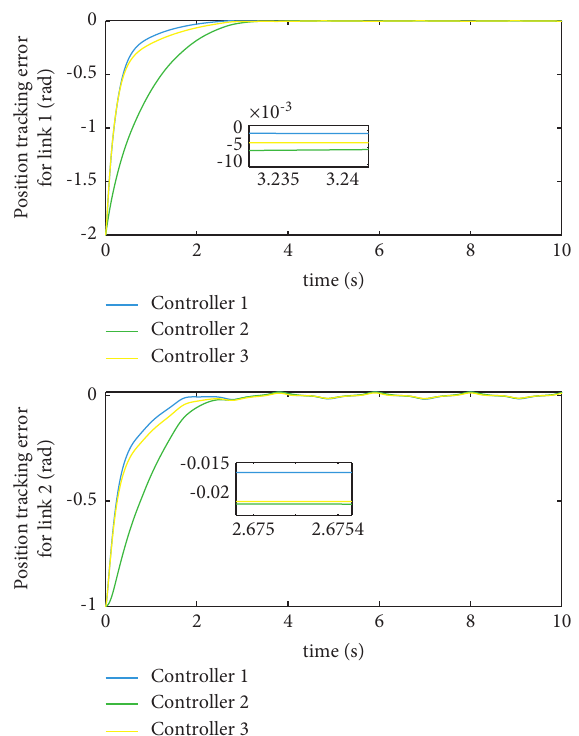
Figure 7: Comparison of tracking error of the